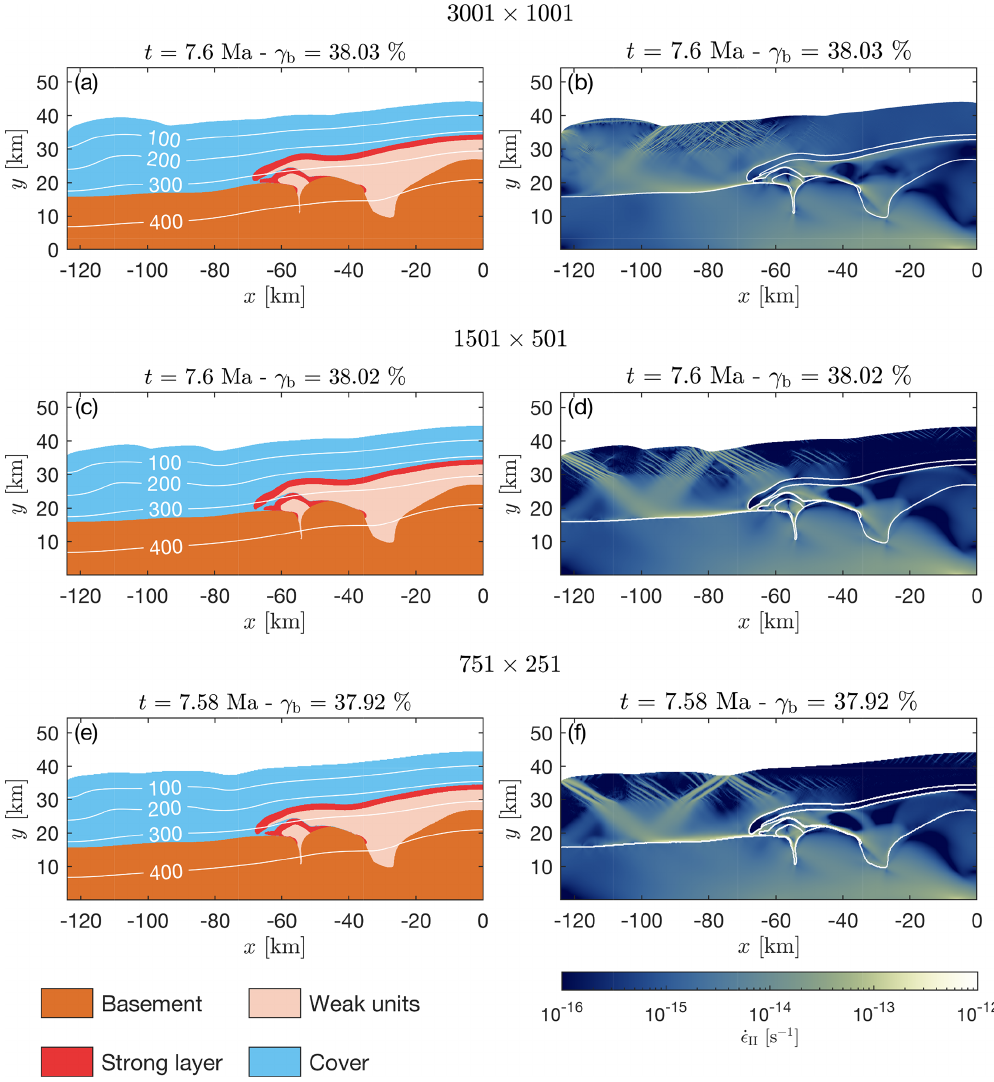
Figure 11. The geometry and the strain rate field of three simulations after approximately 38% bulk shortening for different numerical